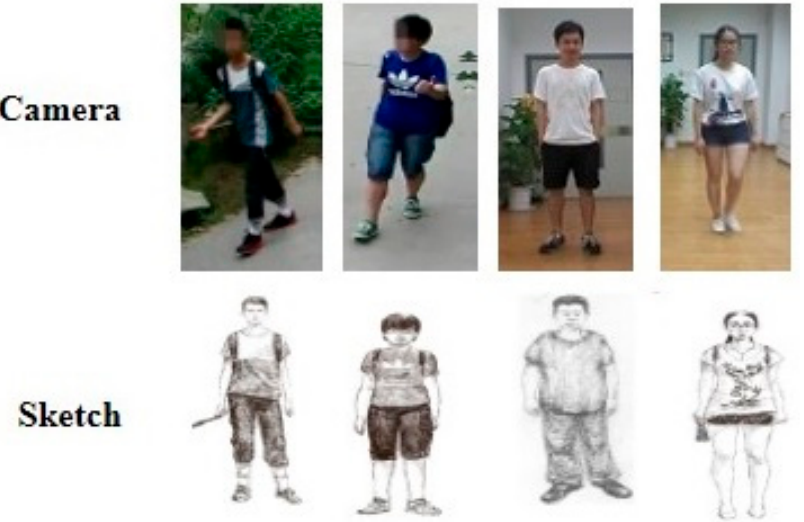
Figure 15. Example images showing sketches of different persons and their corresponding RGB